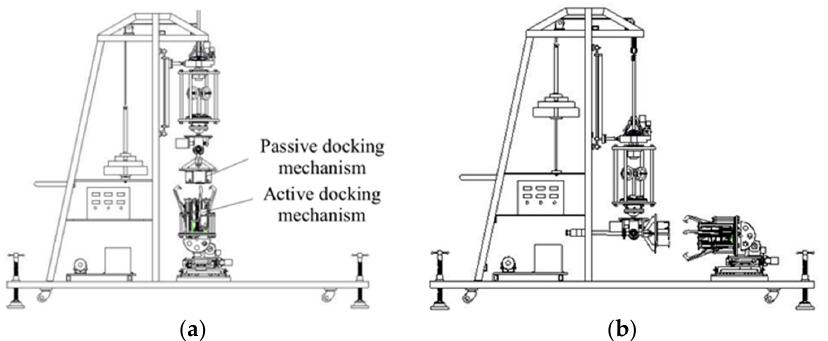
Figure 1. Joint assembly diagrams of the composite docking test platform, ( a ) vertical docking; ( b ) horizontal docking.